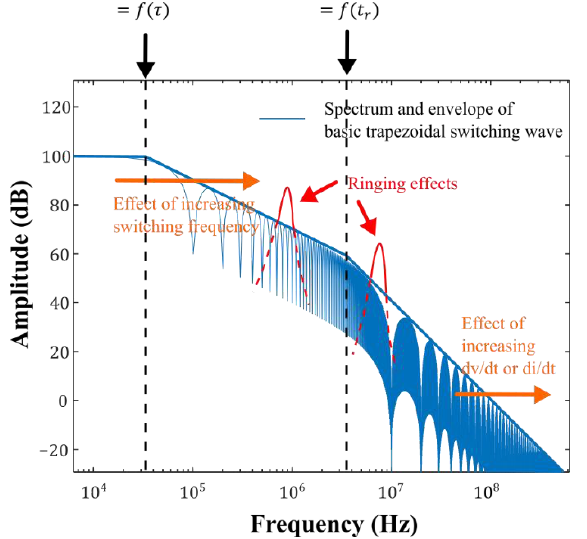
Figure 3. Spectrum and envelope of a basic trapezoidal switching wave and effect of changing parameters such as switching frequency, 𝑑𝑣/𝑑𝑡 or 𝑑𝑖/𝑑𝑡 . In red, appearance of peaks on the envelope due to ringing effects.